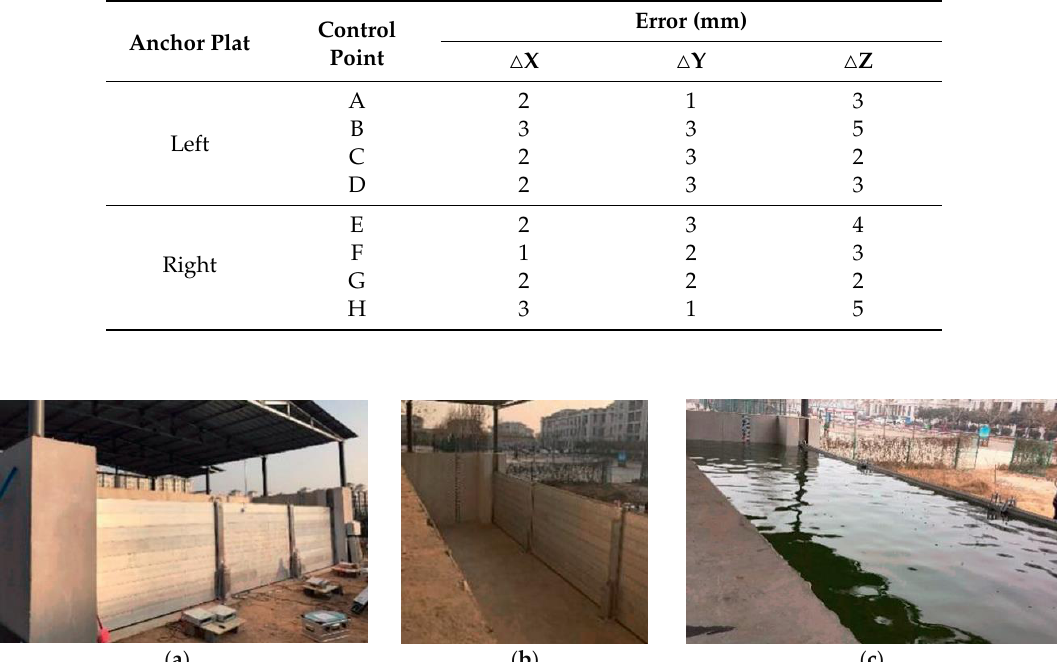
Table 4. Deviation of the control points.